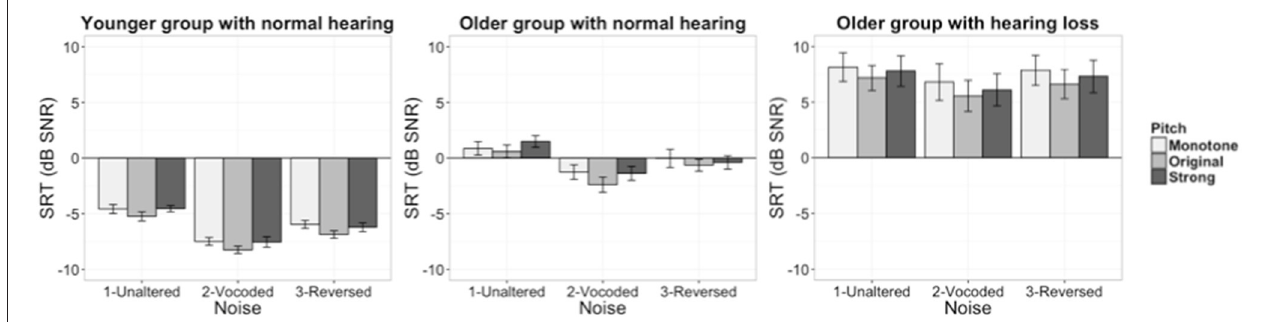
FIGURE 1 | Speech Reception Threshold scores of all listener groups (left panel: younger group with normal hearing, middle panel: older group with near-normal hearing, right panel: older group with hearing loss. Error bars present ± 1 standard error).